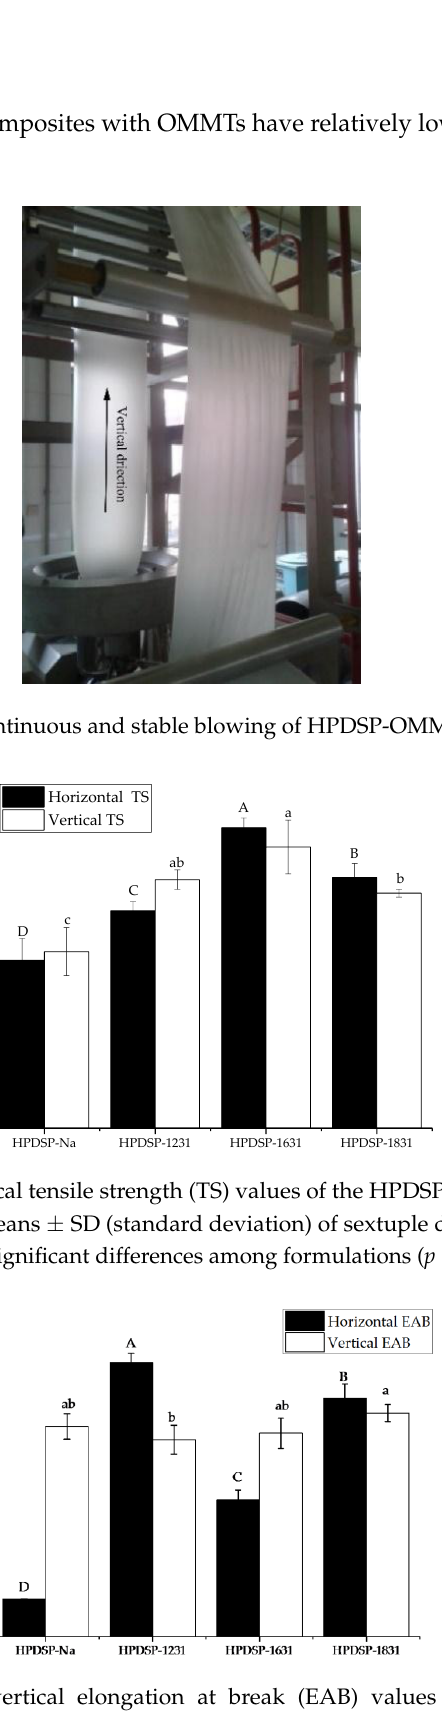
HPDSP-OMMT films. OMMT films. Results are quoted as means ± SD (standard deviation) of sextuple determinations. A–